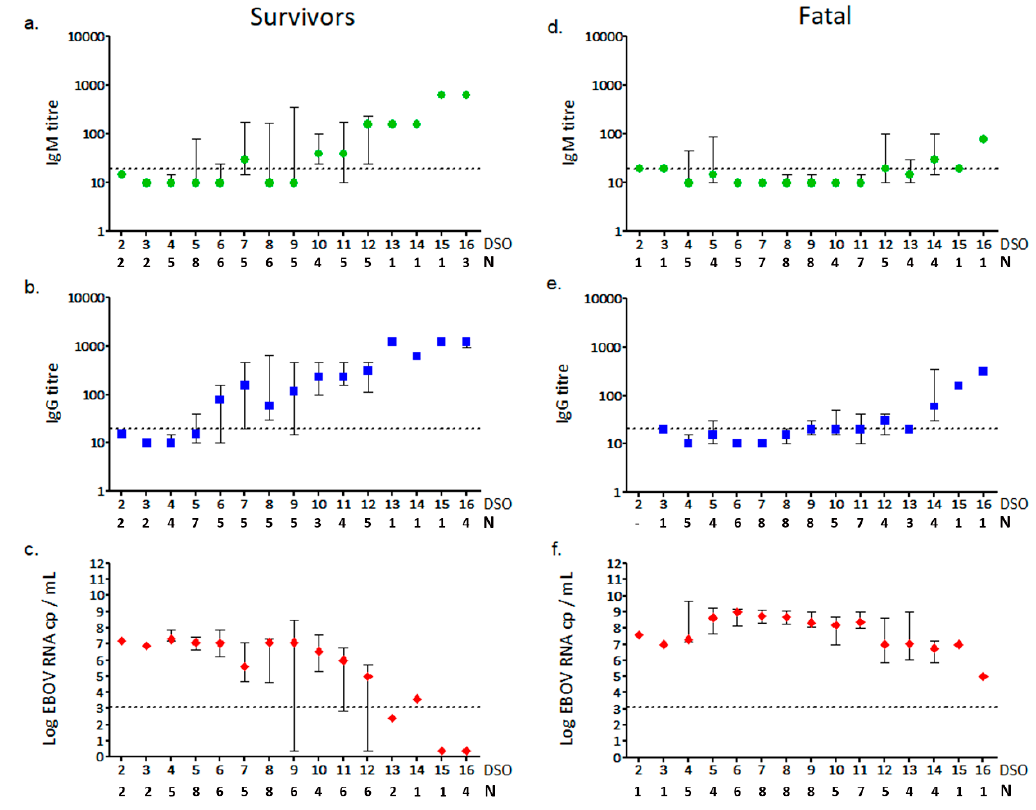
1:320 within 16 DSO in the fatal group with a steady increase in viremia (Figure 3f), while higher titres (up to 1:1280) were observed in survivors as early as at 13 DSO (Table S3).